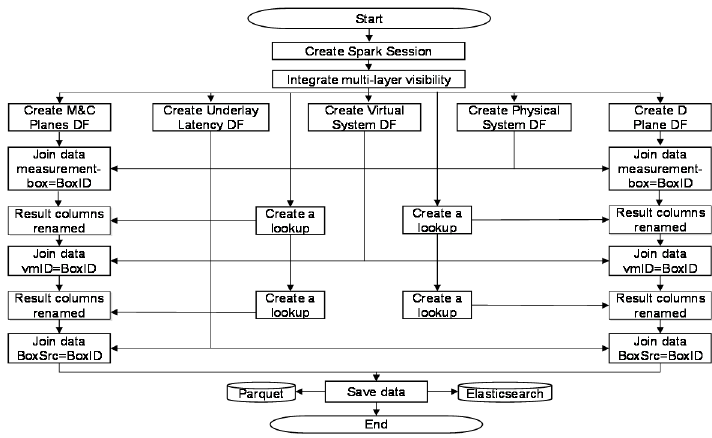
Figure 8. Design of multi-layer visibility data integration